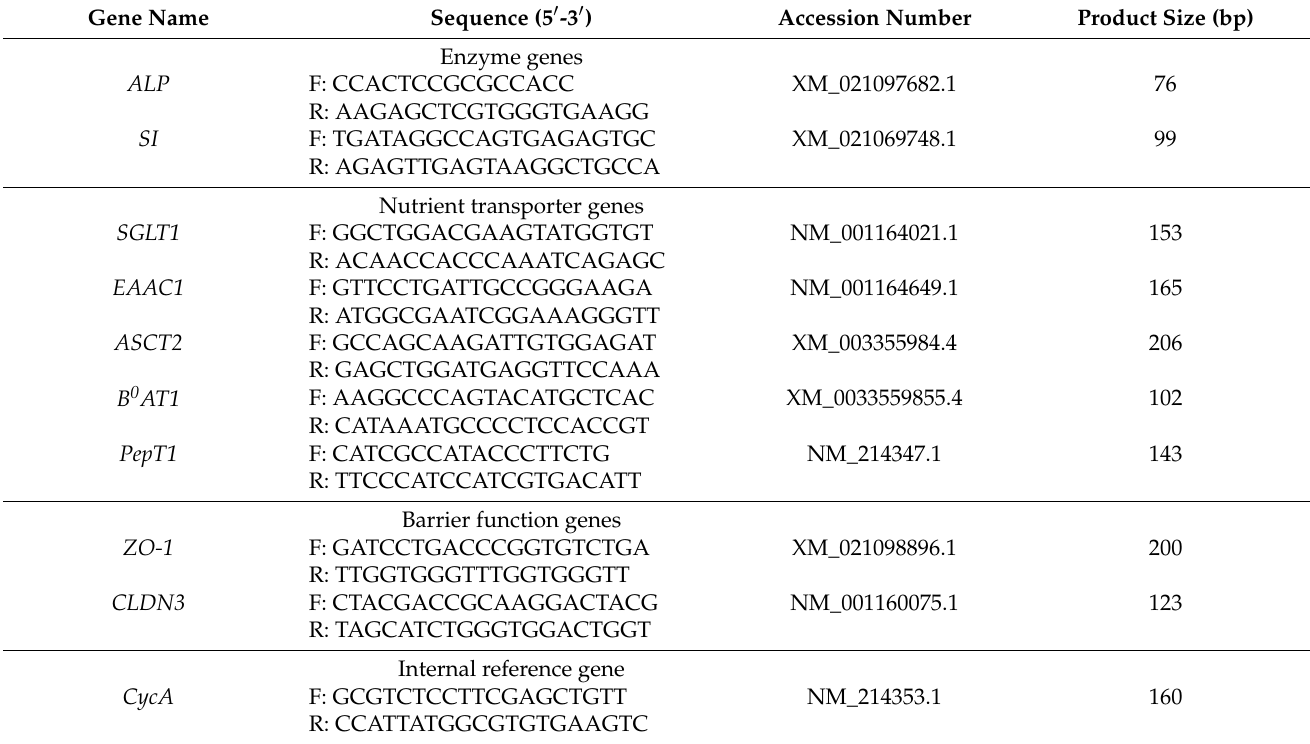
Table 1. The primer sequences of the target genes and the internal reference